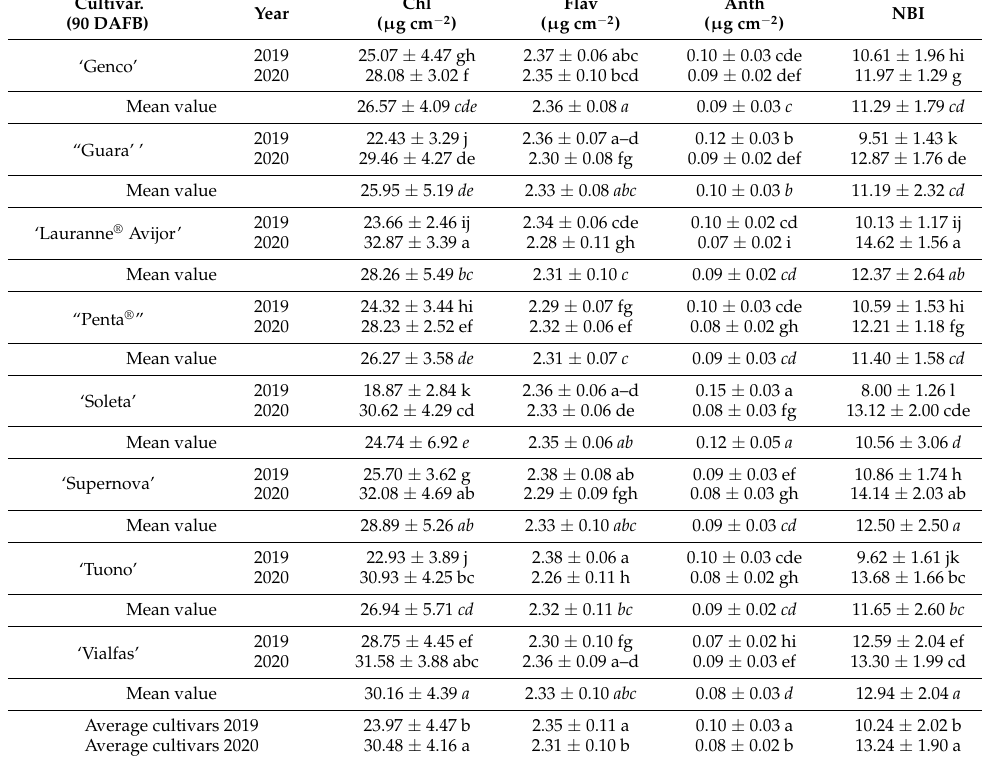
Table 8. Leaf total (Chl), flavonol (Flav) anthocyanin (Anth) and nitrogen balance index (NBI) in almond leaves collected at 90 DAFB over the years 2019–2020. Data are presented as mean ± standard deviation. Different lowercase letters on the columns indicate significant differences between means (Fisher’s test p < 0.05). Lowercase letters in italics describe the differences expressed as two-year mean values of the